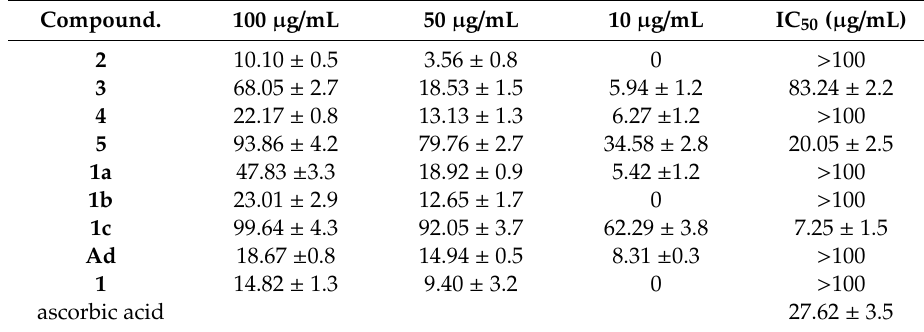
Table 2. Values of (2,2 (cid:48) -azino-bis (3-ethylbenzothiazoline-6-sulfonic acid) (ABTS) radical scavenging activity (percentage, %) were measured at 745 nm and compared to the values obtained for the control, ascorbic acid. Values are averages of triplicate